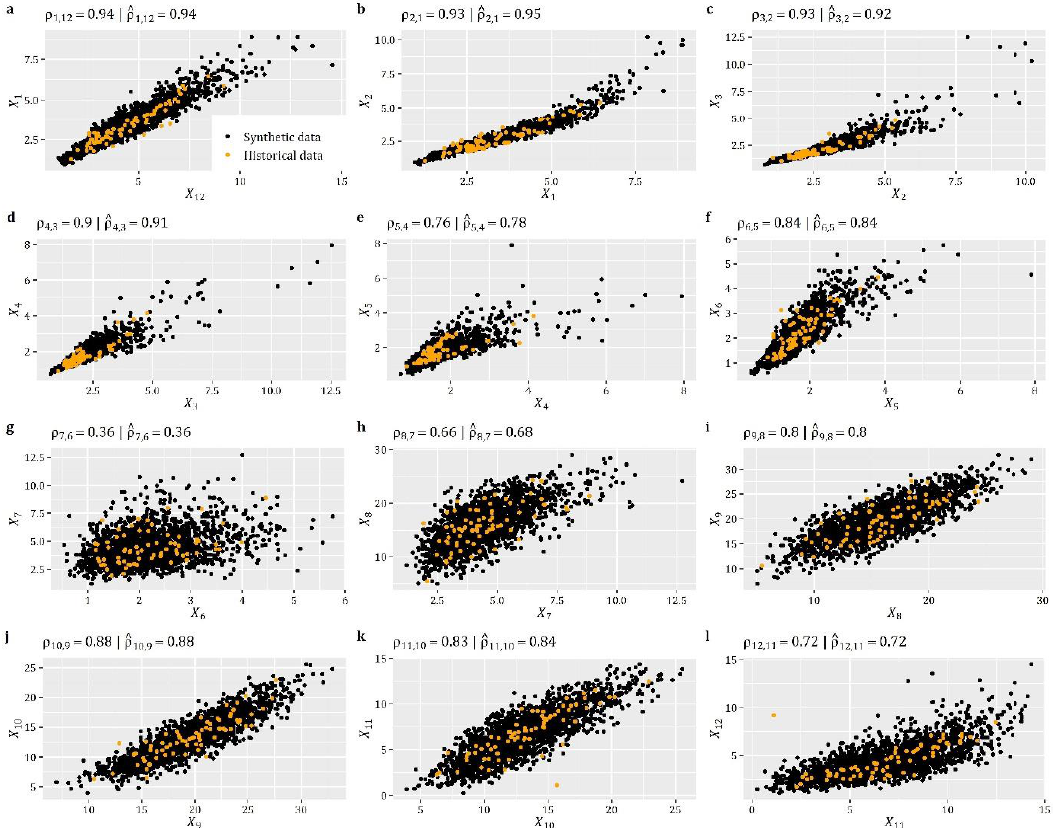
Figure 14. Month-to-month ( a – l ) scatter plots of historical and simulated Nile streamflow data (10 9 m 3 ). The title of each subplot provides the lag-1 month-to-month target (𝜌 𝑠,𝑠−1 ) and simulated (𝜌̂ 𝑠,𝑠−1 ) correlation coefficients.